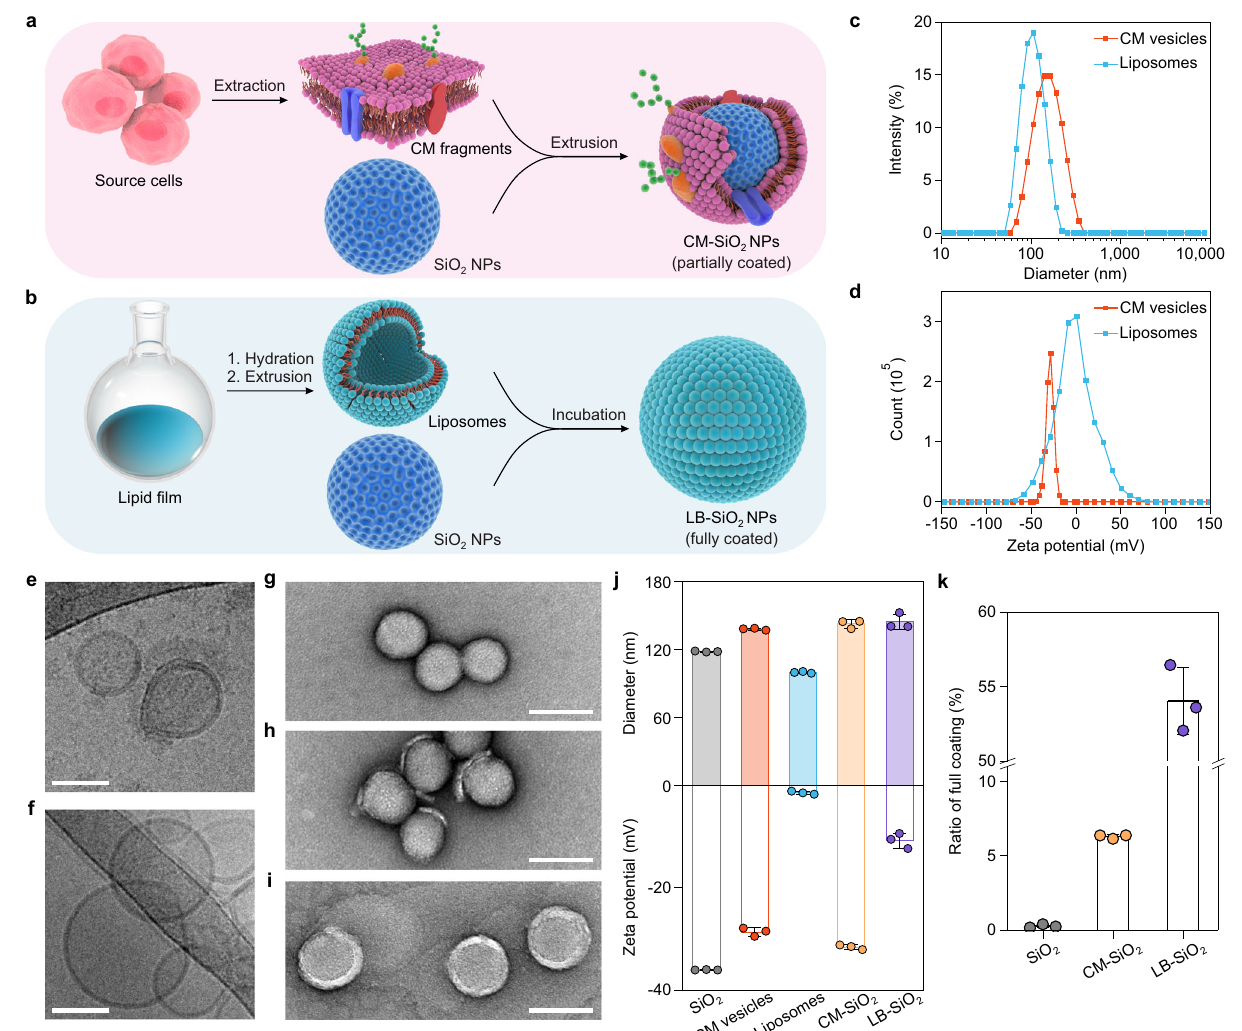
Fig. 1 | Comparison of cell membrane (CM) coating and lipid bilayer (LB) coating. a Schematic illustration of the preparation of CM-coated SiO 2 (CM-SiO 2 ) NPs through a physical co-extrusion method. b Scheme depicting the synthesis of LB-coated SiO 2 (LB-SiO 2 )NPs. c , d Sizedistribution( c )andzetapotential( d )ofCM vesicles and liposomes, as measured by DLS. e , f Cryo-TEM images of CM vesicles ( e ) and liposomes ( f ). Scale bars, 50nm. g – i TEM images of bare SiO 2 NPs ( g ), CM-